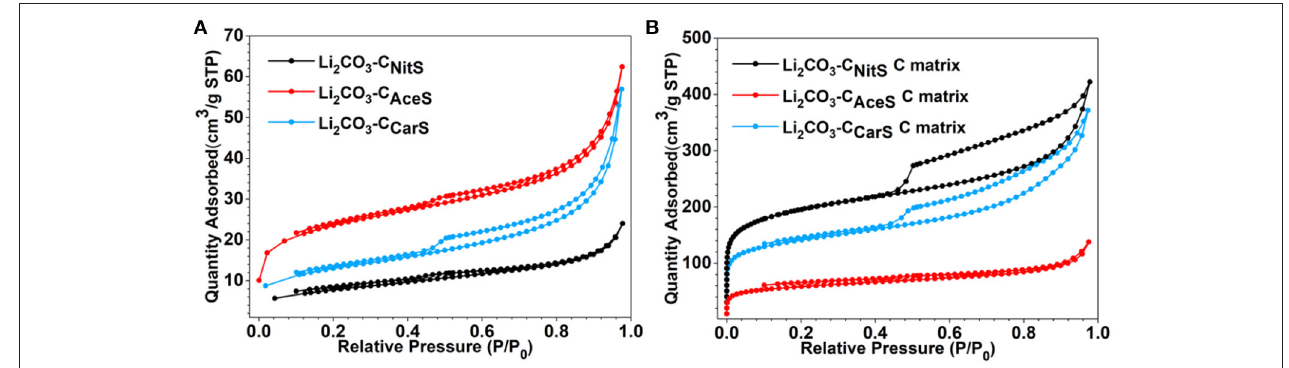
FIGURE 3 | N 2 adsorption-desorption isotherms of (A) Li 2 CO 3 -C nanoparticles and (B) the carbon matrix after Li 2 CO 3 removal.